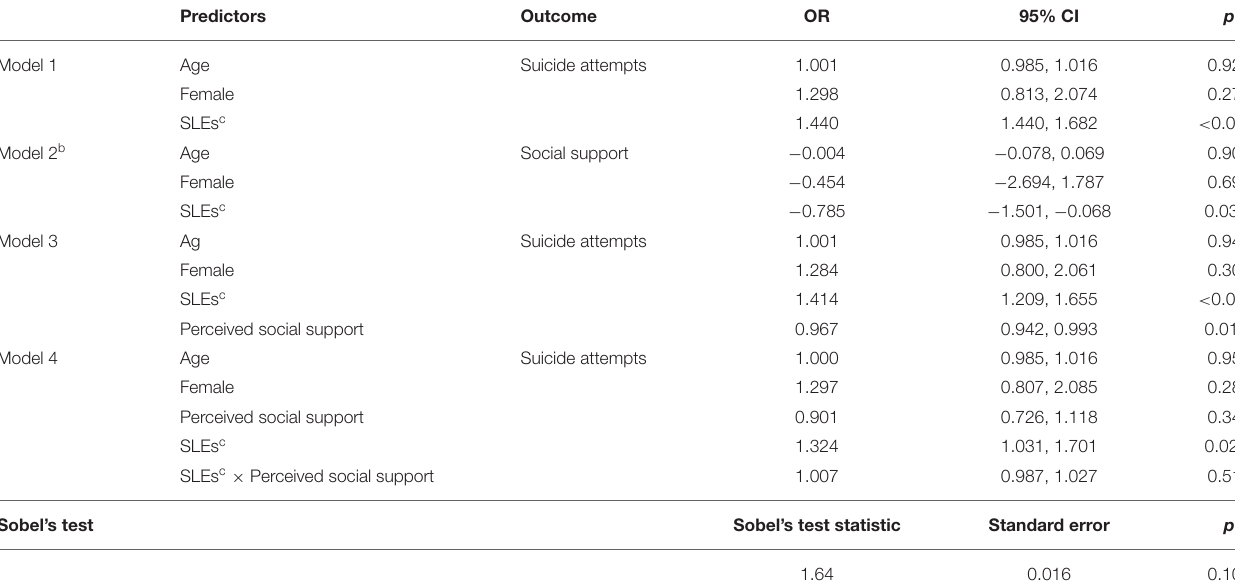
TABLE 2 | Logistic and linear regression results from mediation and moderation analyses with suicide attempts as the outcome a